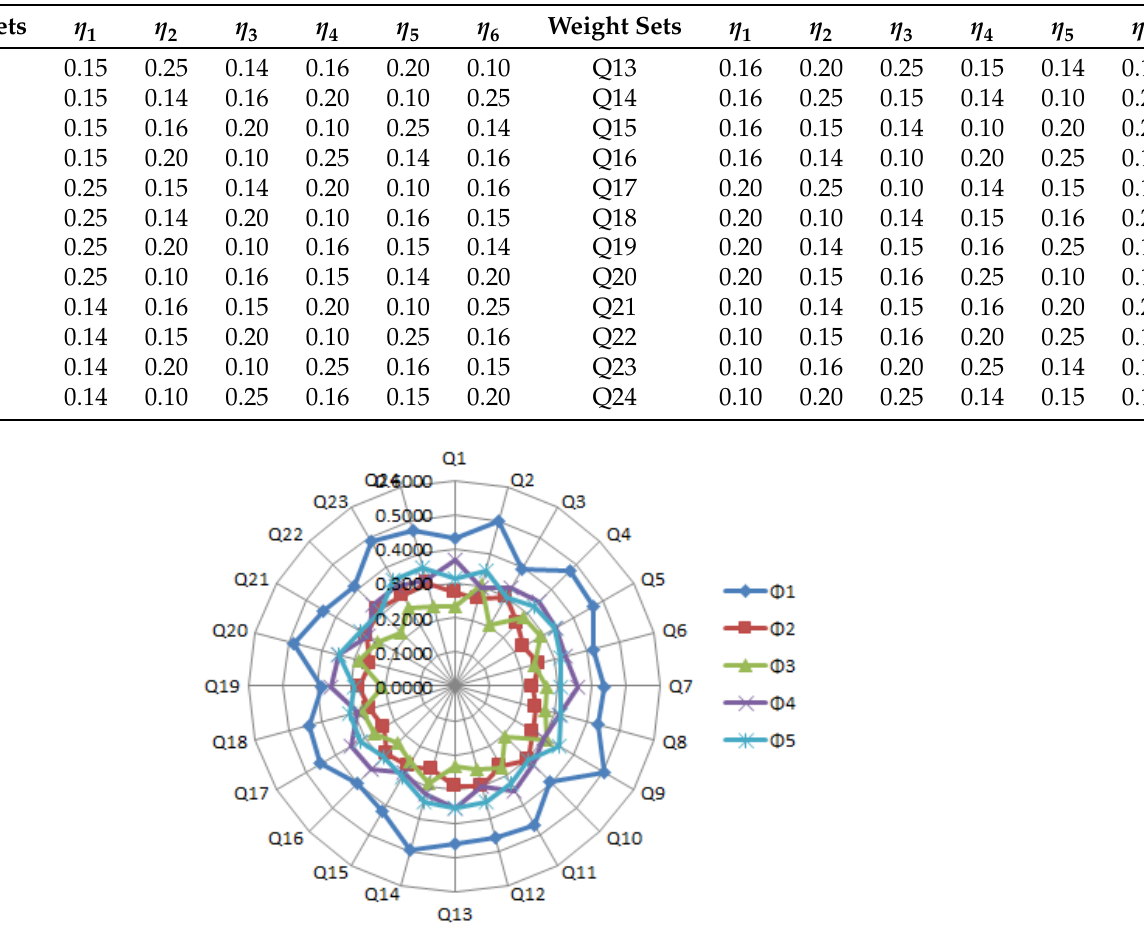
Table 4. Various weight sets of criteria.